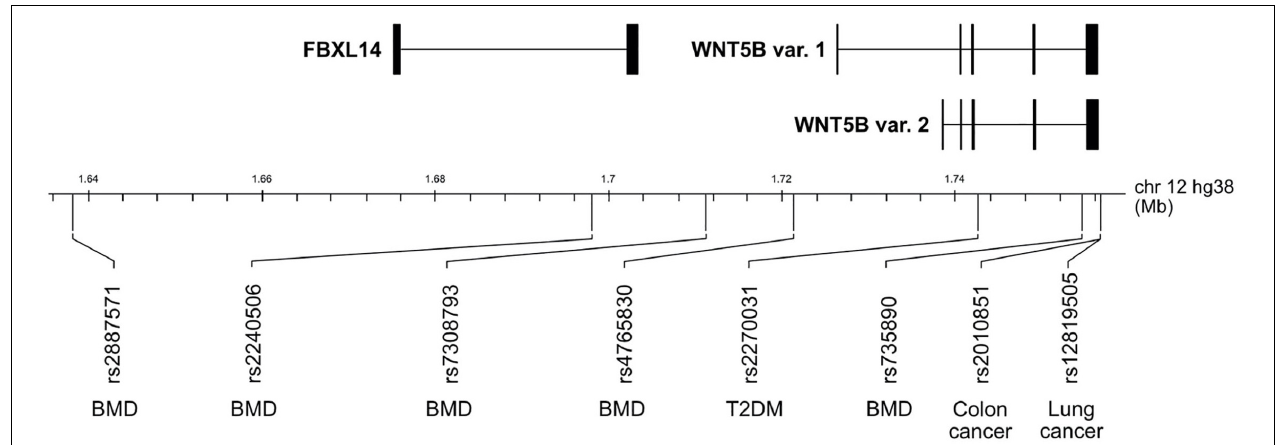
FIGURE 3 | WNT5B single nucleotide polymorphisms (SNPs) in 12p13.33 implicated in disease. SNP rs2887571, rs2240506, rs7308793, rs4765830, and rs735890 are associated with variations in BMD. SNP rs2270031 is linked to Type 2 diabetes mellitus (T2DM). SNPs rs2010851 and rs12819505 are associated with colon cancer and lung cancer,